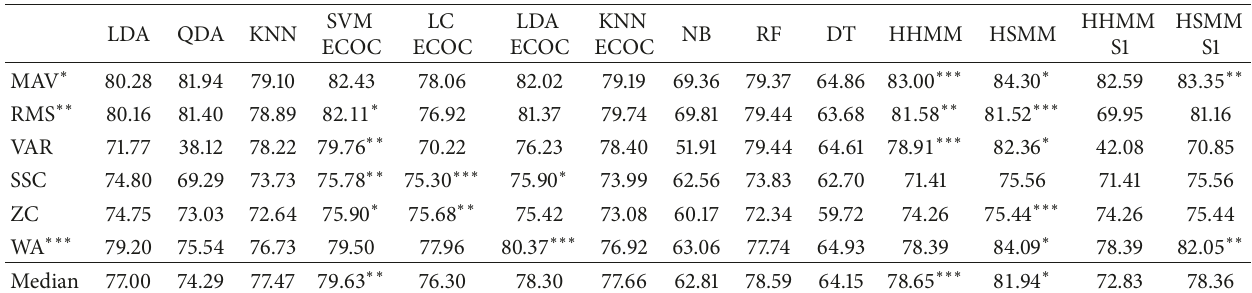
Table 1: Classifier accuracy in % for LDA, QDA, knn (15), SVM ECOC, LC ECOC, LDA ECOC, KNN ECOC, NB, HHMM, HSMM, and HHMM with only one segment per movement and HSMM with one segment per movement. The top ranked classifiers are marked with ∗